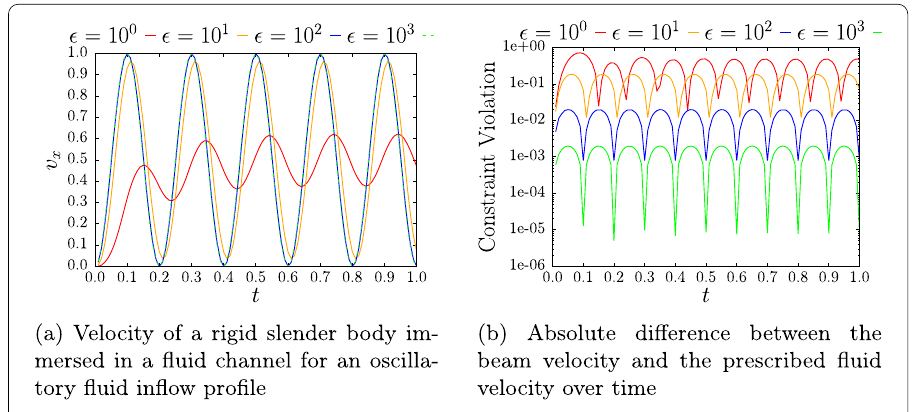
Fig. 14 Behavior of an immersed freely moving beam in dependence of the penalty parameter